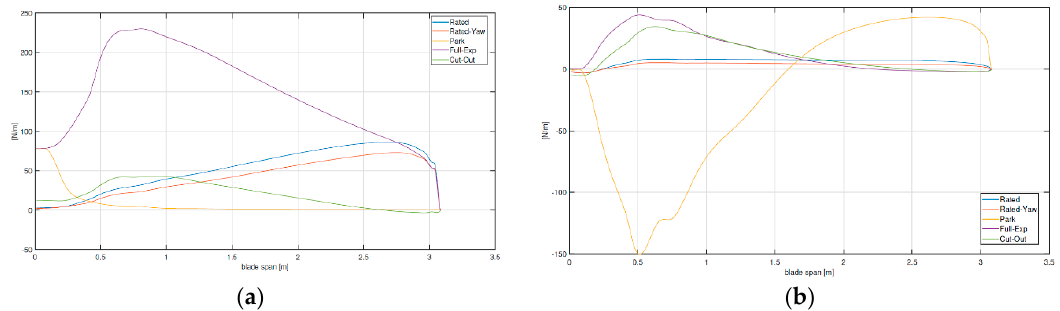
Figure 13. Blade force per unit length: ( a ) normal to the rotor plane (positive downwind) and ( b ) tangential to the rotor plane (positive in the blade rotation direction. Table 7. Blade–root loads for the design load cases. F N is the force normal to the rotor plane, F T the tangential force, M FN the out-of-plane bending moment and M FT the torque.